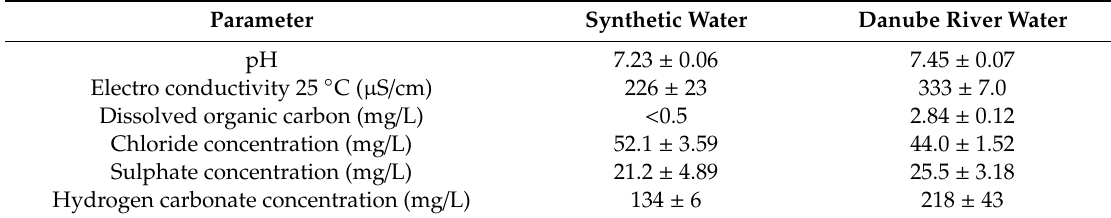
Table 3. Characteristics of the synthetic water and Danube river